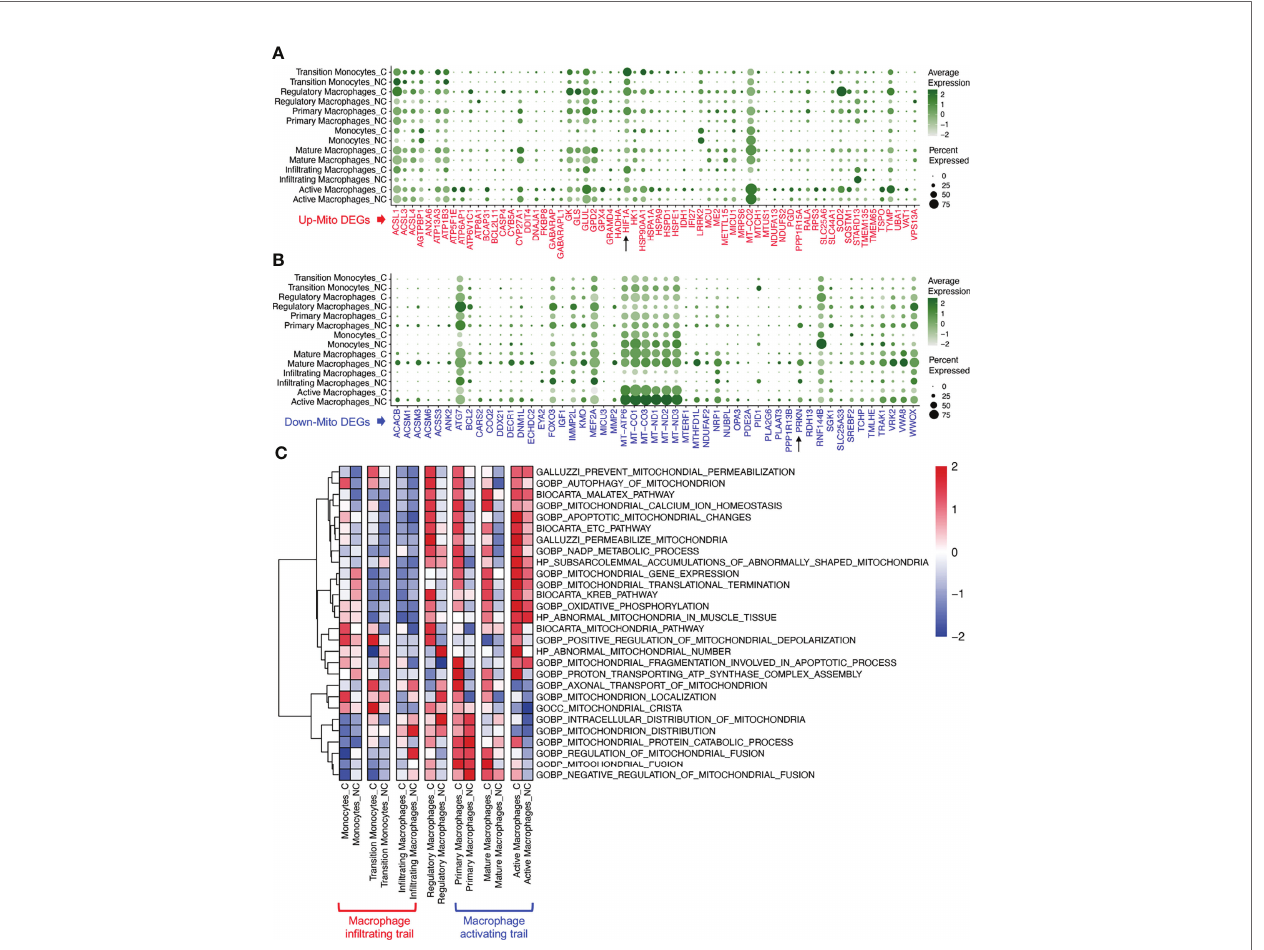
FIGURE 3 | Mitochondrial functions of macrophage subsets in COVID-19 lung tissues. (A) Bubble chart of upregulated mito-DEGs of macrophage subsets in COVID-19. (B) Bubble chart of downregulated mito-DEGs of macrophage subsets in COVID-19. (C) GSVA of mitochondrion-related pathways in macrophage subsets in